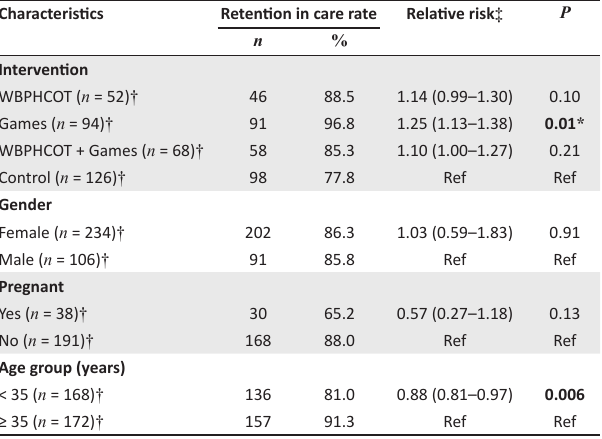
TABLE 3: Factors associated with retention in care, considered as a binary outcome. Characteristics